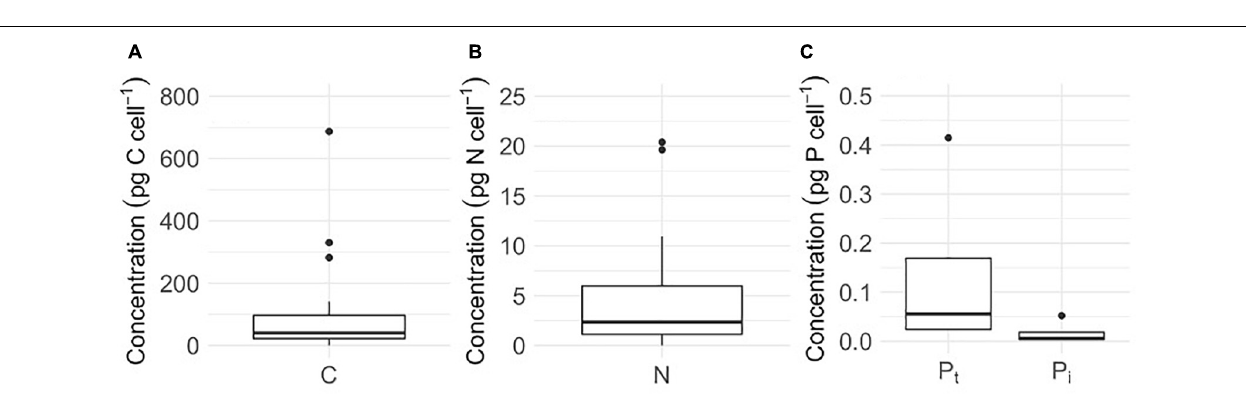
FIGURE 2 | Cellular concentrations of (A) carbon (C, n = 28), (B) nitrogen (N, n = 28), (C) total phosphorus (P t , n = 4), and (C) inorganic phosphorus (P i , n = 4) of glacier algal assemblages comprised of Ancylonema cf. nordenskiöldii , cf. Mesotaenium berggrenii, and Cylindrocystis brebissonii in surface ice from the south western margin of the Greenland Ice Sheet (GrIS) during the mid-2019 ablation season. Plots show median ± interquartile